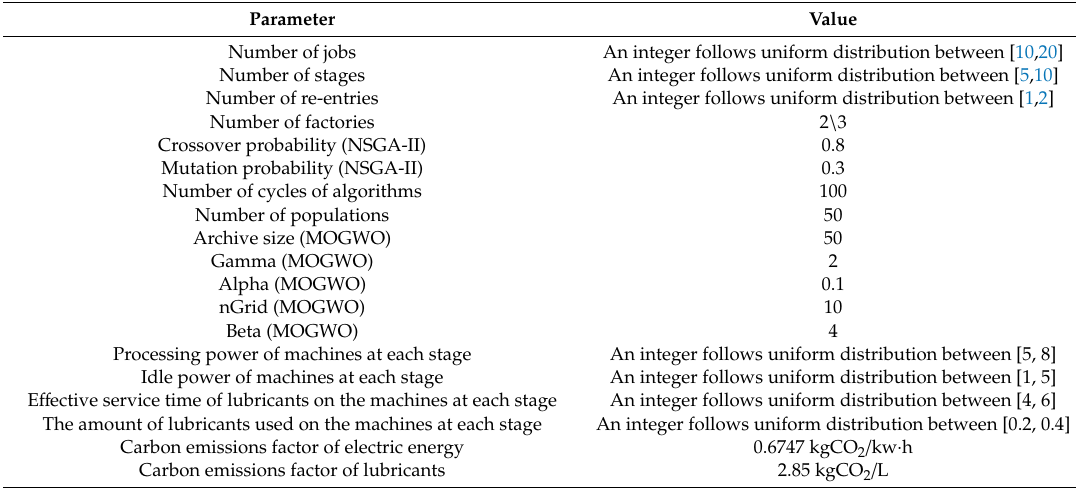
Table 5. Parameters and values of